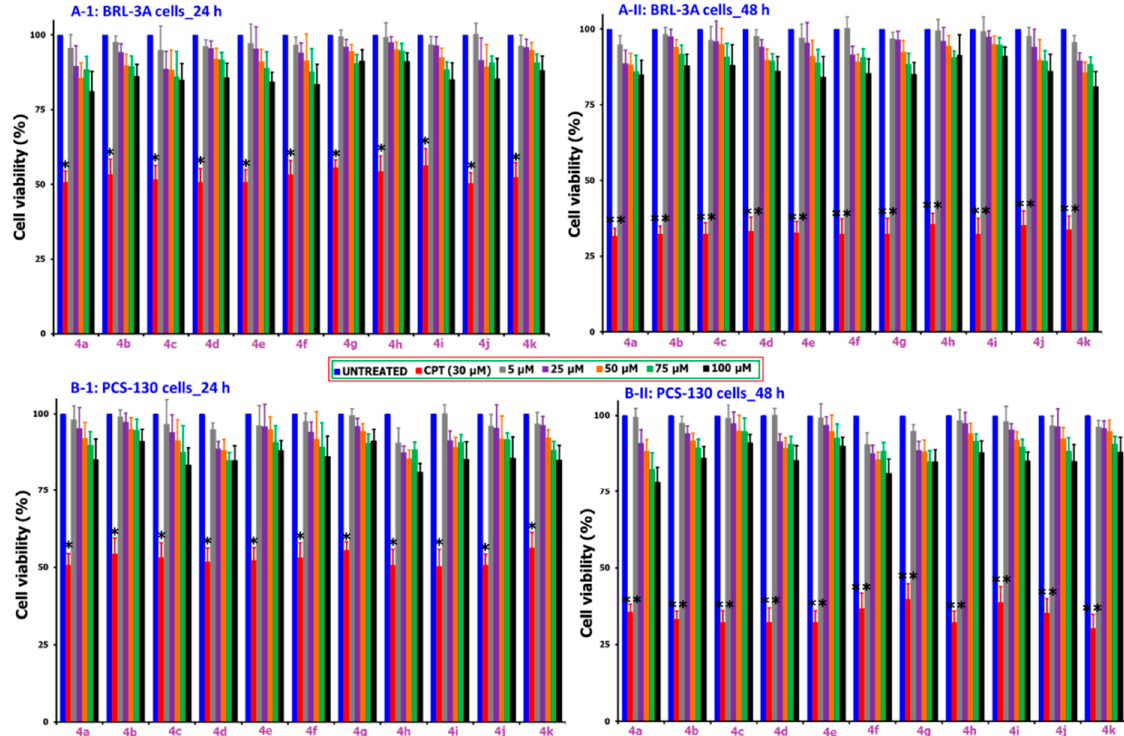
Figure 3. MTT assay comparison of BRL-3A and PCS-130 non-cancer cells at the two different intervals of 24 h and 48 h for the samples 4 ( a – k ) over a concentration range of 5–100 μ M.